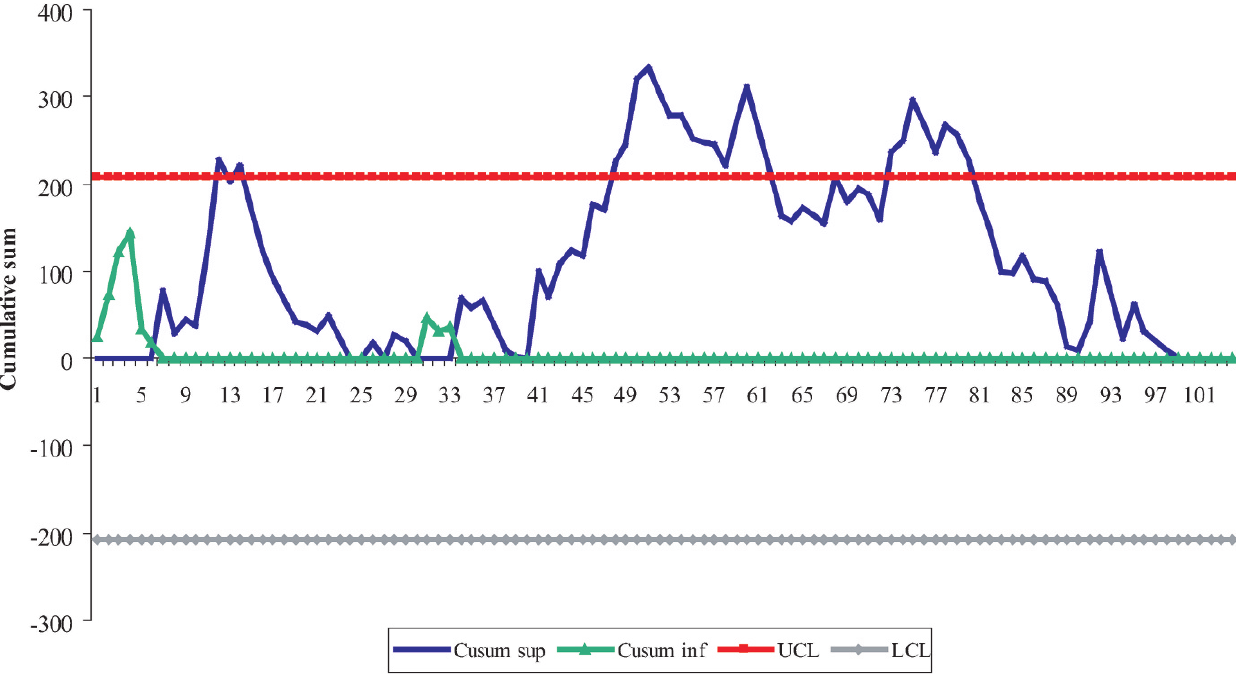
Figure 4 - The CUSUM control chart of incidence densities per 1,000 patients/day in the adult ICU of CH. The parameters used were K=0.5 and H=5